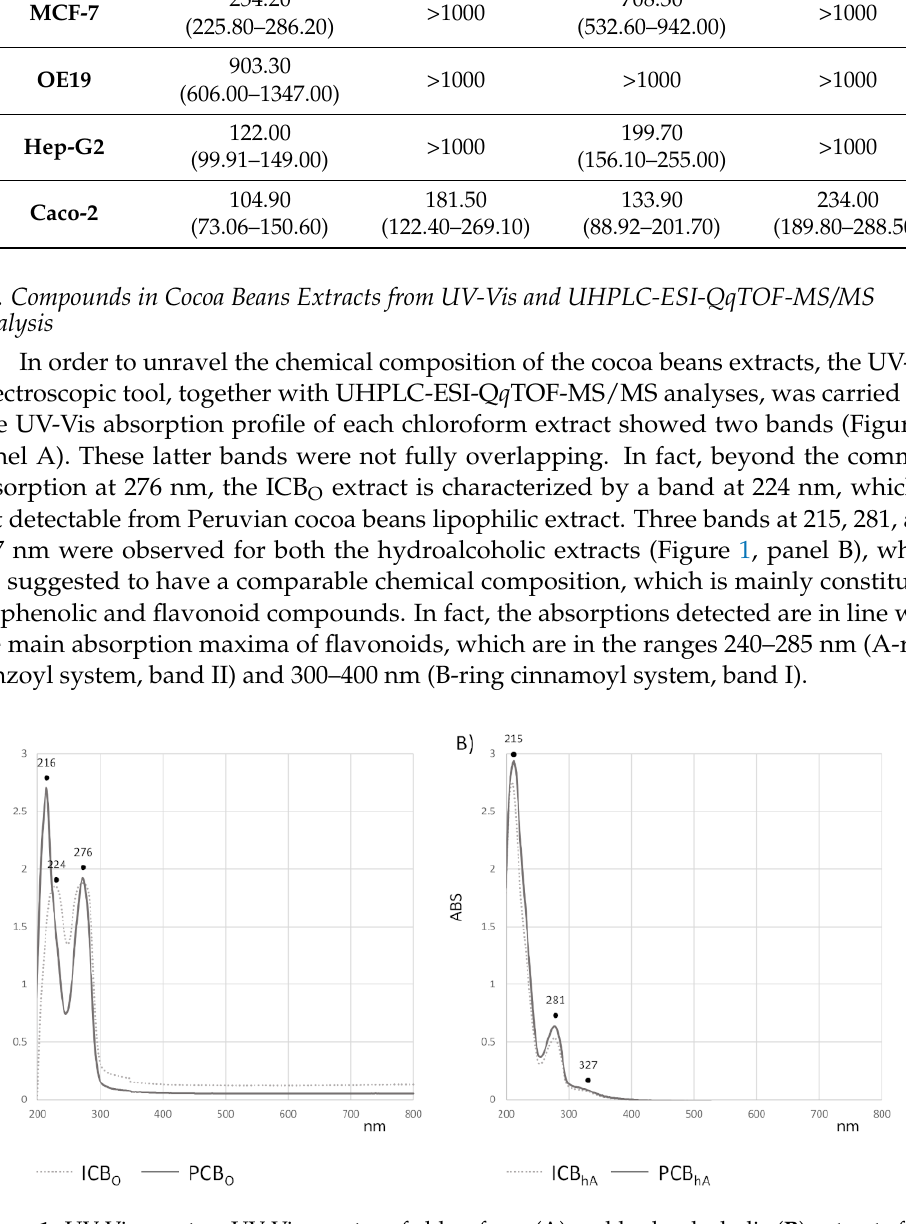
Figure 1. UV-Vis spectra. UV-Vis spectra of chloroform ( A ) and hydroalcoholic ( B ) extracts from Indonesian (dashed line) and Peruvian (continuous line) cocoa beans. Spectra are recorded in the range 200–800 nm. The bands’ wavelength is